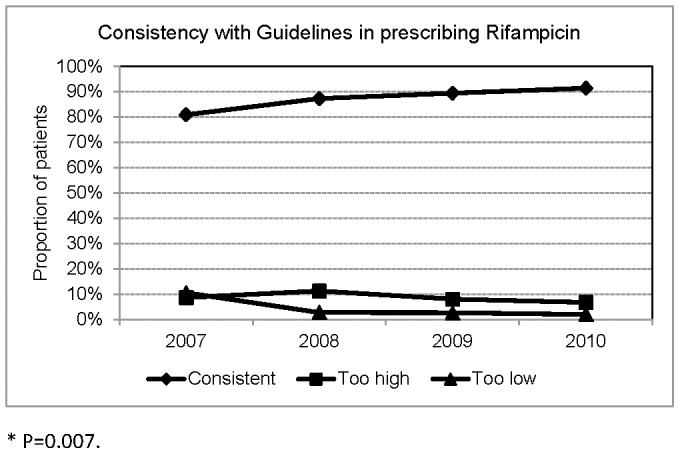
Consistency with Taiwan Guidelines in prescribing Rifampicin.